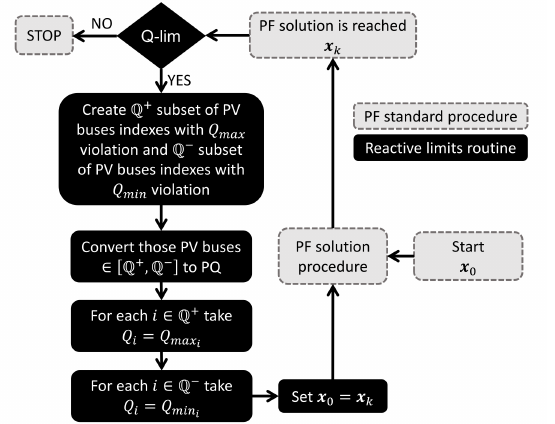
Figure 1. Flowchart of the considered strategy for handling with reactive limits in generation